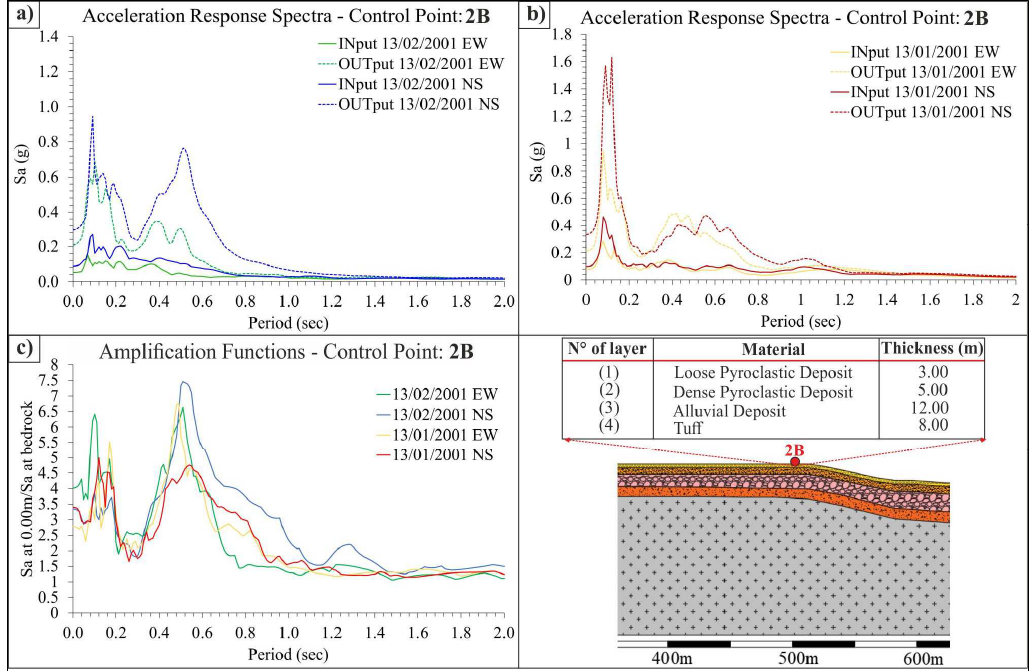
Figure 19. Section BB′: numerical control point 2B spectral responses obtained by 2D numerical analyses using LSR2D software. ( a ) Comparison among the SA of the two components of the 13 February 2001 earthquake. ( b ) Comparison among SA of the two components of the 13 January 2001 earthquake. ( c ) Amplification functions related to the four input